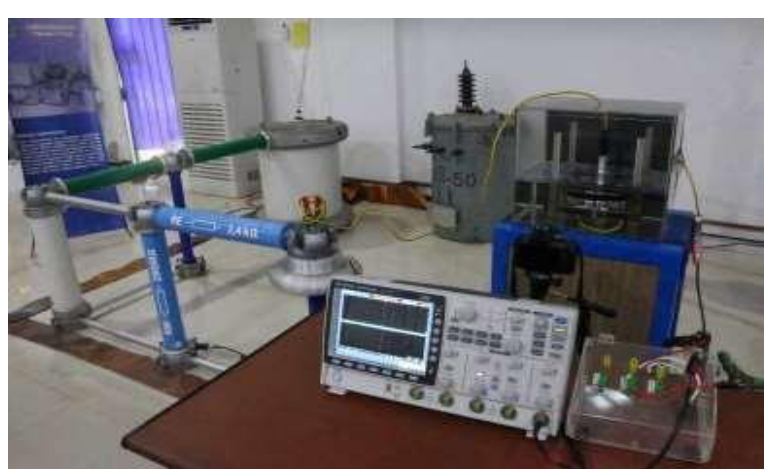
Figure 1. Configuration of experiment.